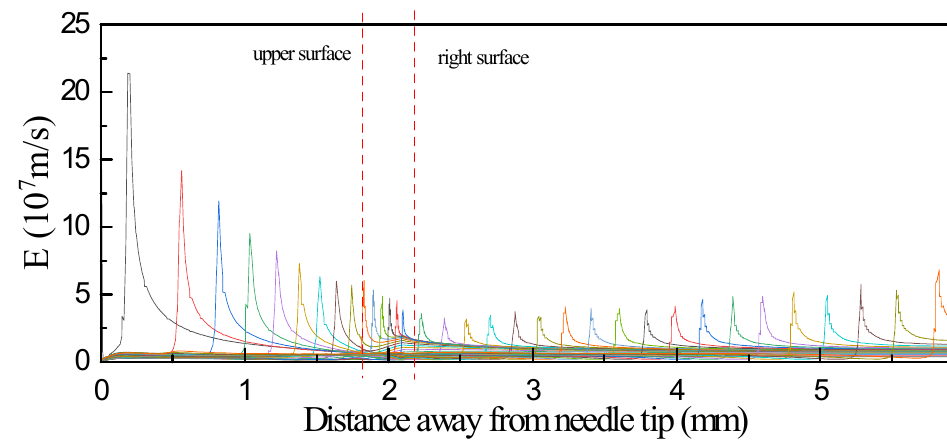
Figure 5. Electric field changes during streamer development. After that, the streamer enters the transition stage, from the upper surface of the insulator to the right surface. This stage has the slowest development speed. And the electric field at the streamer head is also the smallest, because the distance from the needle